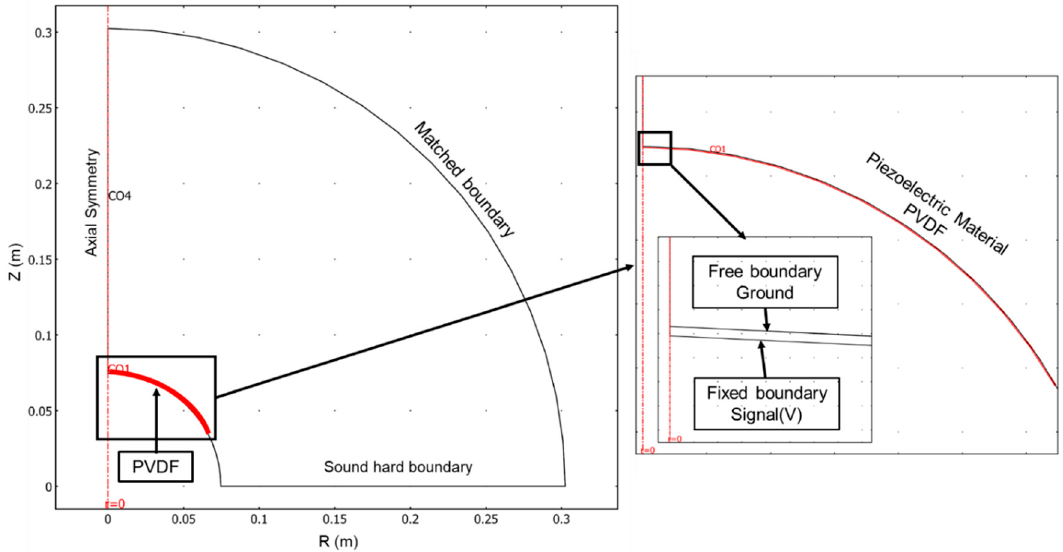
Figure 2. Boundary conditions definition for the 2D symmetric geometry FEM simulation, composed of a 30 cm radius medium and the transducer active element.